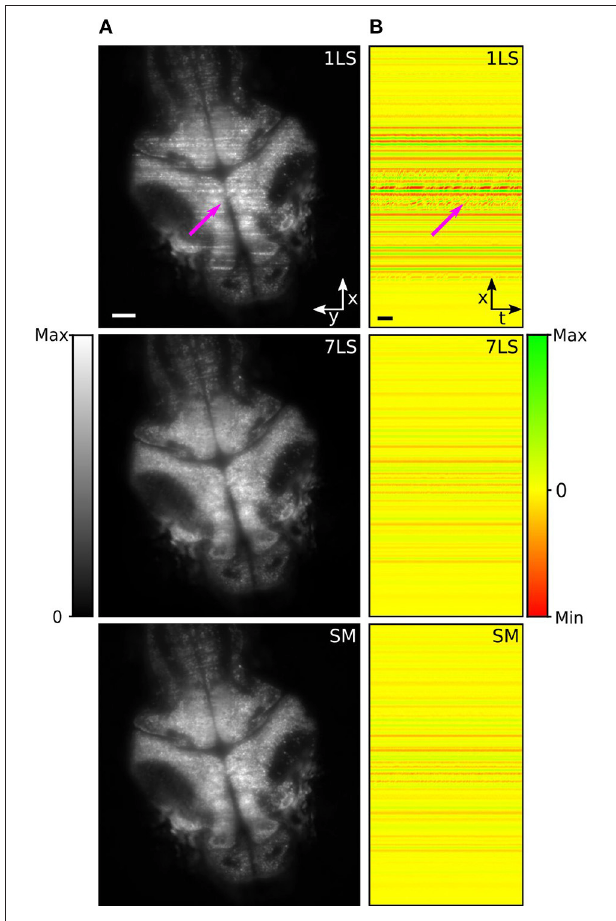
FIGURE 3 | (A) LSFM images of a zebrafish-larva brain taken with either a single or seven static light-sheets or with a single pivoted one. (B) Maps of spatial correlation along the x-axis (integrated over the y-axis), for the respective illumination configurations, with respect to the modeled stripe artifact. The images were generated by color-mapping the Pearson correlation coefficient, as detailed by the color bar, and the results for the different temporal frames of the time-lapse acquisition are displayed along the horizontal dimension. A subset of stripe artifacts produces fluorescence variations over time that lead to intermittent features in the correlation maps, like the one marked by the arrow. A second arrow in (A) marks the position of the corresponding artifact in the original image. Size scale bars of 50 µ m, time scale bar of